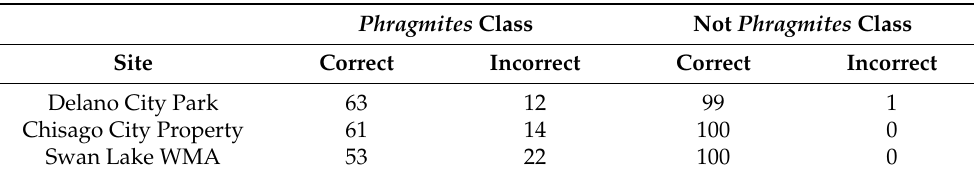
Table 12. Validation assessment points for each of the three validation sites for the artificial neural network classification with the post-ML OBIA rule set.